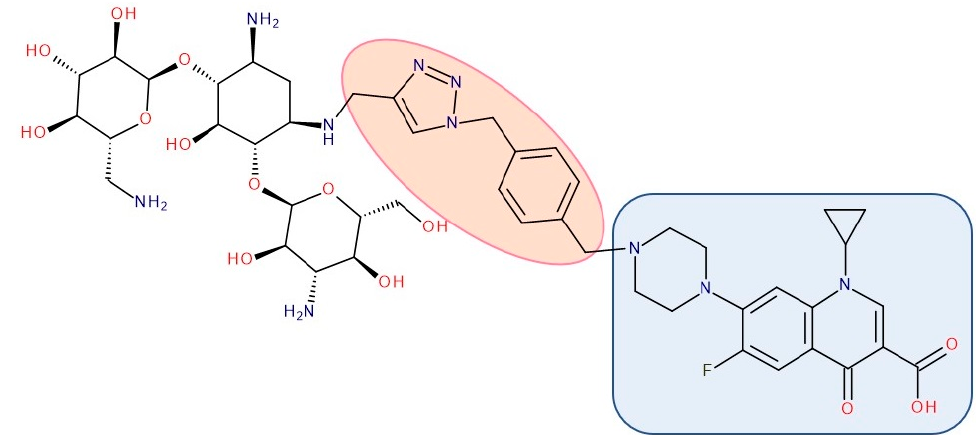
Figure 13. Antibiotic–antibiotic hybrid containing an FQN: kanamycin A–linker–ciprofloxacin; the linker is highlighted with the orange circle while the QN/FQN unit is highlighted by the blue rectangle [210].